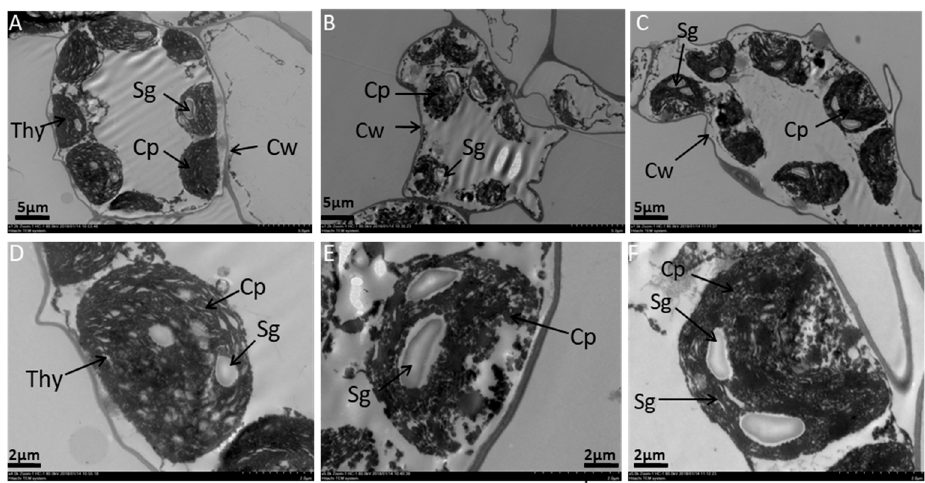
Figure 3. Transmission electron microscopy (TEM) of mesophyll cells of the middle part of the midrib of a leaf, from the top of the plant at the first inflorescence stage. ( A – C ) figure shows the TEM structure of whole leaf mesophyll cell of control, SAR, and 100 μ M Mel + SAR plants, respectively; ( D – F ) figure shows the relatively low magnified view of mesophyll cells of the plant of control, SAR, and 100 μ M Mel + SAR plants, respectively. Here, Cp, Cw, Thy, and Sg means chloroplast, cell wall, thylakoids, and starch grana, respectively.